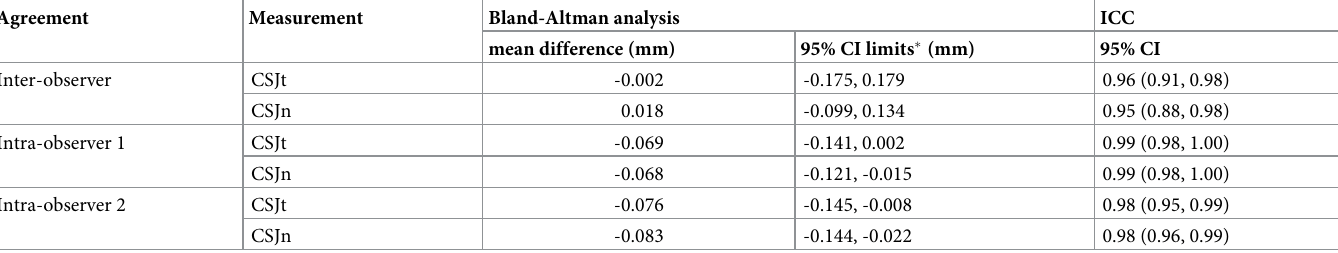
Table 5. Inter- and intra-observer agreement of manual CSJt and CSJn measurements.